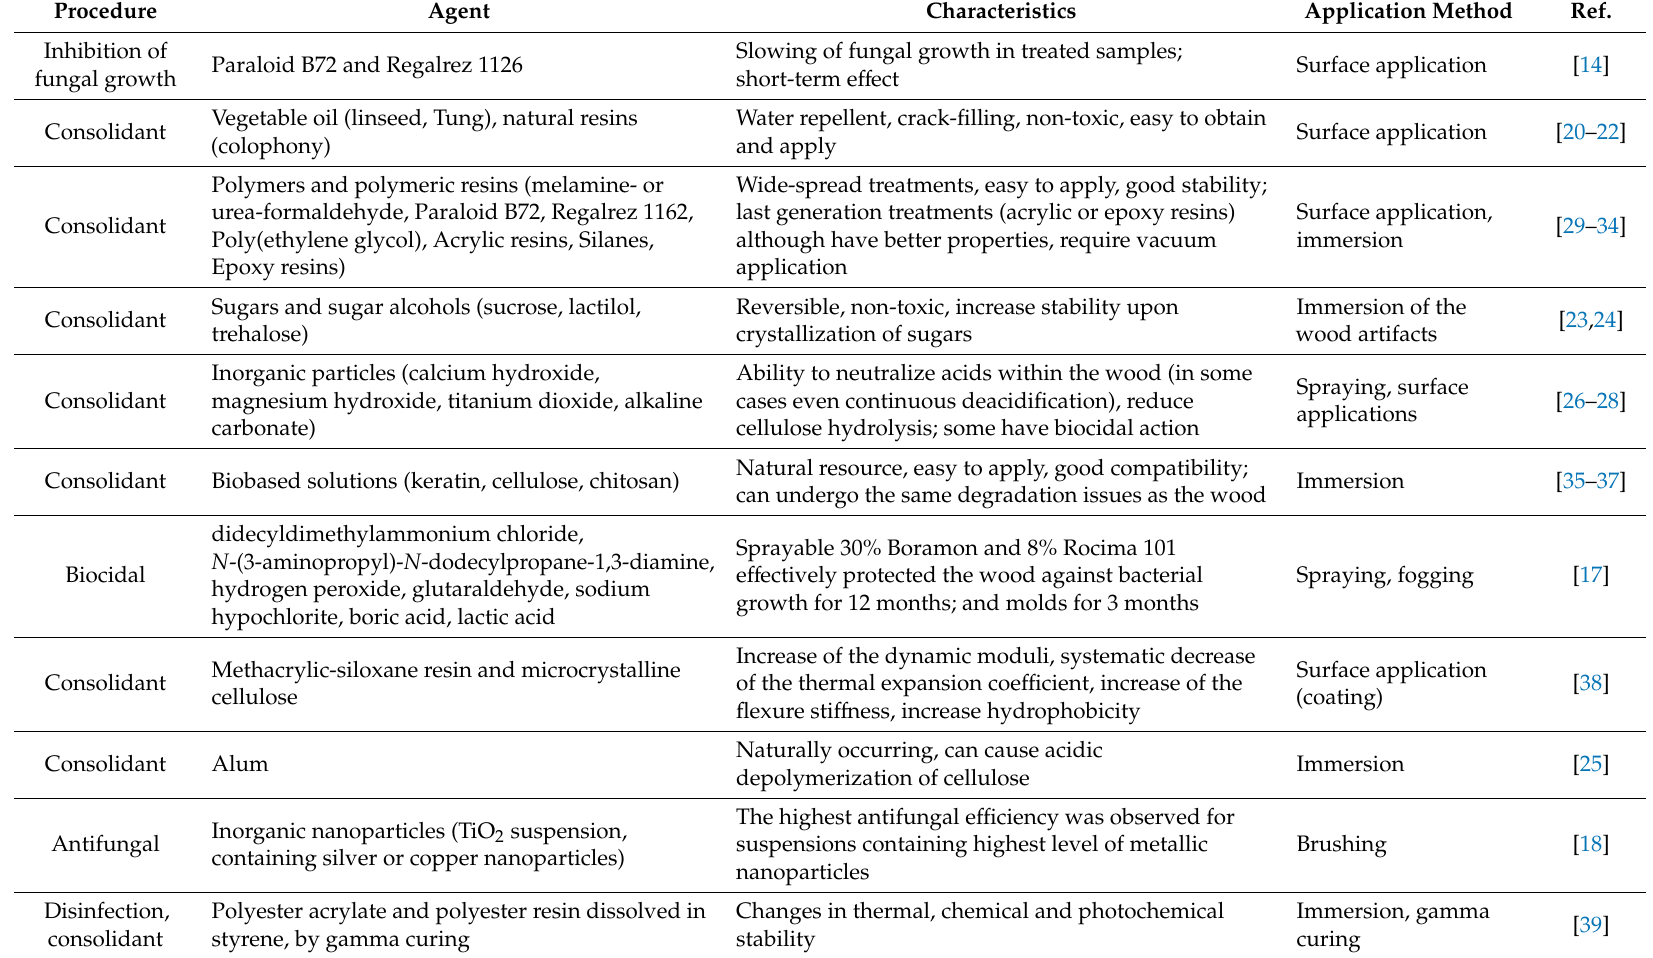
Table 1. Classic and modern conservation agents for wood artifacts (references presented in chronological